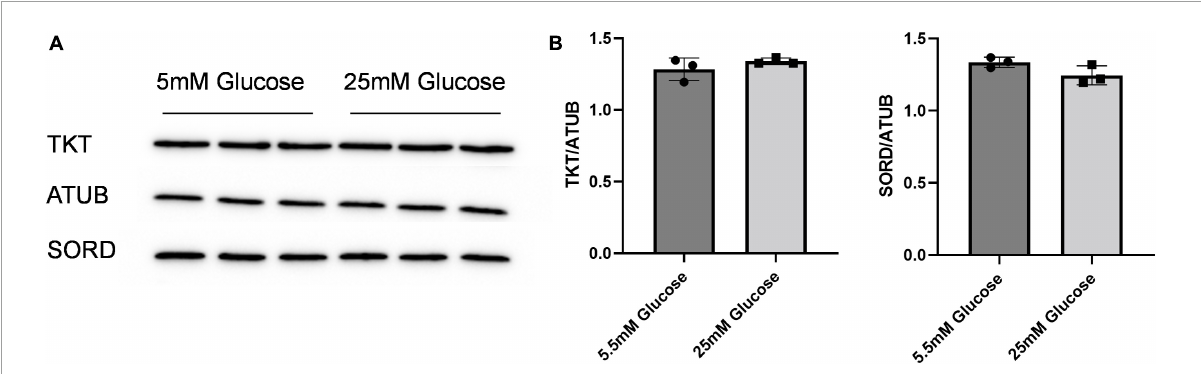
FIGURE5 SORD and TKT protein expression do not increase in response to high glucose media. (A) Western blot of TKT and SORD expression after 48 h treatment in 5.5 mM or 25 mM glucose media and (B) quantification. Expression was quantified with ImageJ ( n = 3). ATUB, alpha tubulin; SORD, sorbitol dehydrogenase; TKT, transketolase.